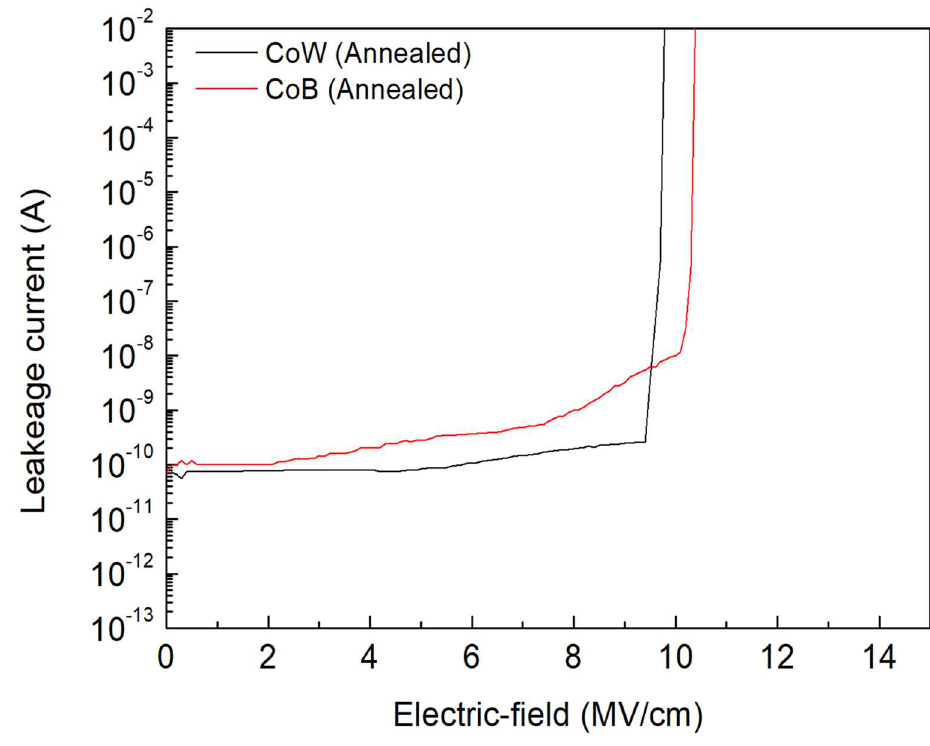
Figure 5. I-E plots of annealed CoW-gate and CoB-gate MIS capacitors. Additionally, the breakdown field of the annealed CoB-gate MIS capacitor was 10.37 ± 0.55 MV/cm, which was higher than that of the annealed CoW-gate sample (9.72 ± 0.35 MV/cm). An increased breakdown field for the annealed CoB-gate MIS capacitor is